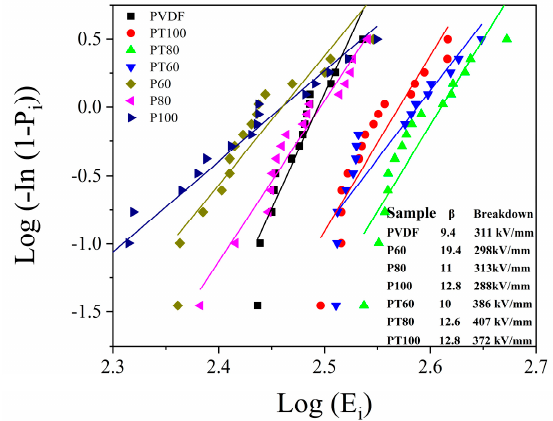
Figure 6. Breakdown Weibull diagram and breakdown scatter diagram.